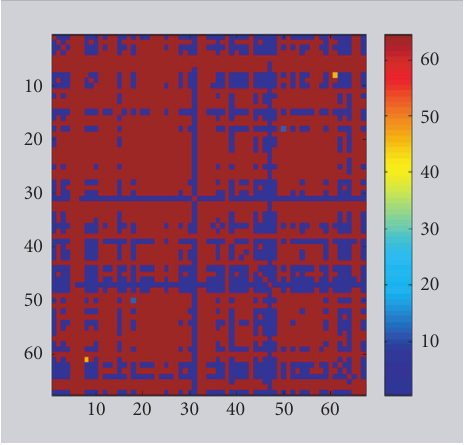
Figure 6. Pattern recognition using δ B